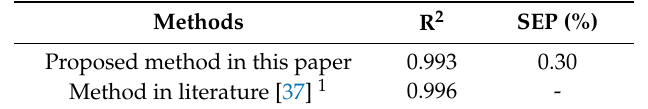
Table 5. The accuracy of the moisture content of barley measured by the proposed method versus methods of